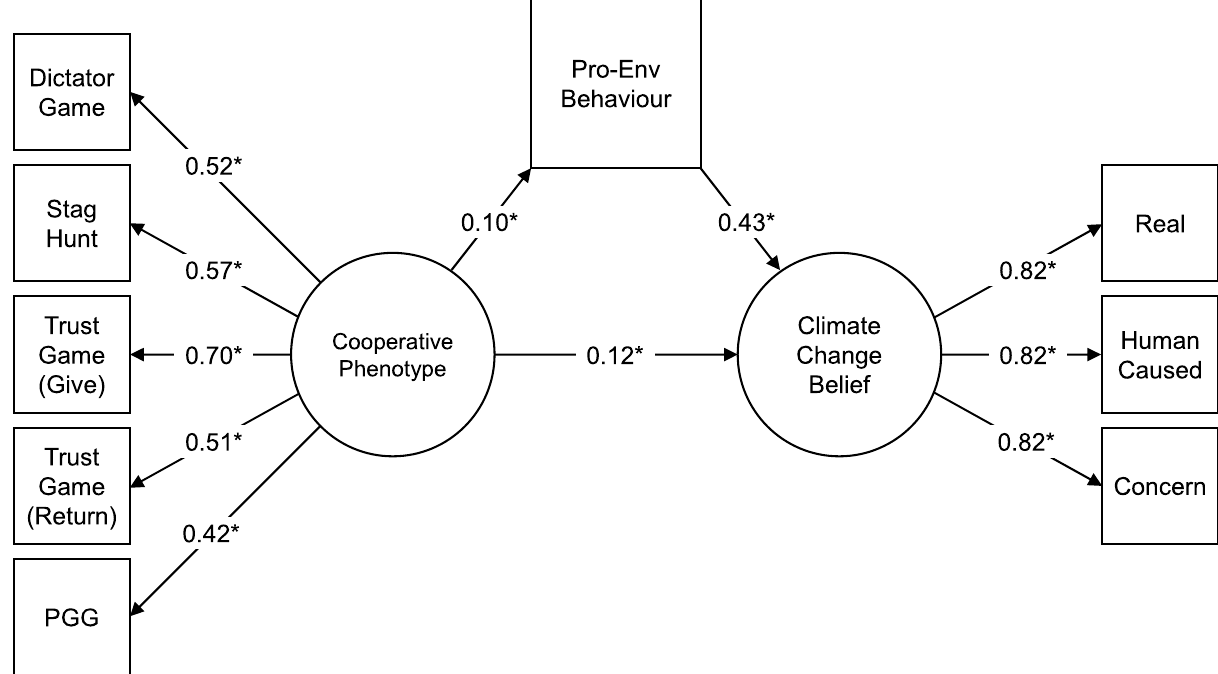
Figure 3. Structural equation mediation model (N = 897). Regressing the climate change belief factor on the cooperative phenotype factor, mediated by pro-environmental behaviour. Note: this visualisation does not include paths from the full model predicting game behaviour from game comprehension. Numbers are standardised parameter estimates; * p <